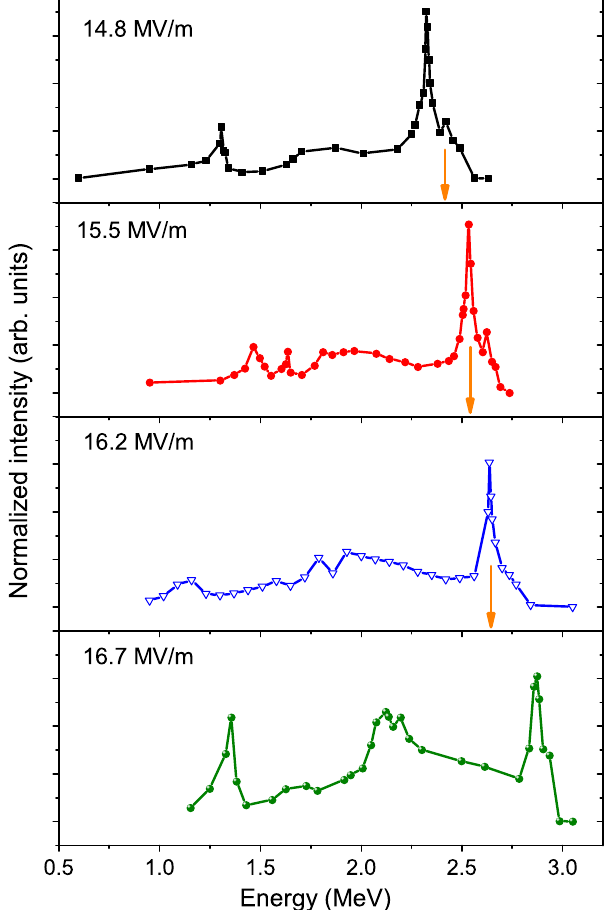
10. Energy spectra of the dark current vs gradient for the SRF gun with the same Cs 2 Te photocathode. The cathode voltage was set to 3 kV. The orange arrows indicate the energy of the photoelectron beam (laser phase